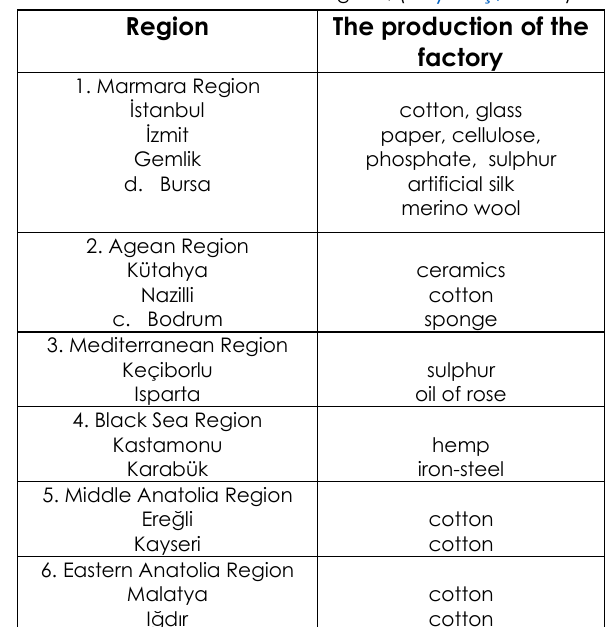
Table 2. The factories and their regions, ( Tayanç, 1973